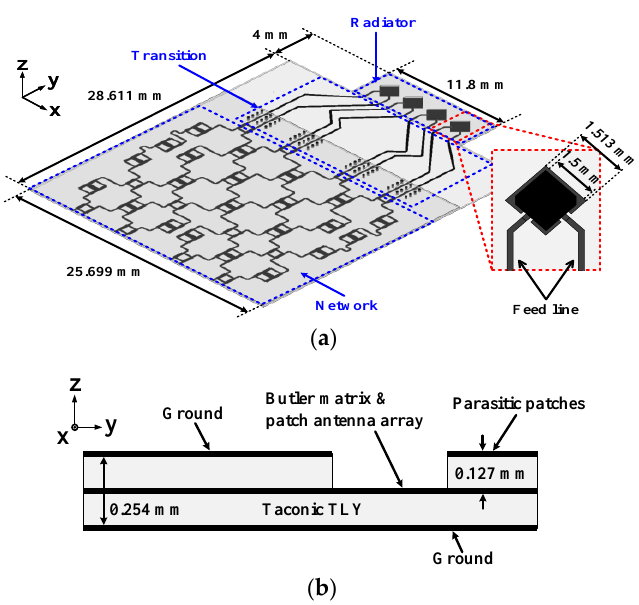
Figure 2. Configuration of the proposed antenna array system: ( a ) 3D-view and ( b ) side-view.